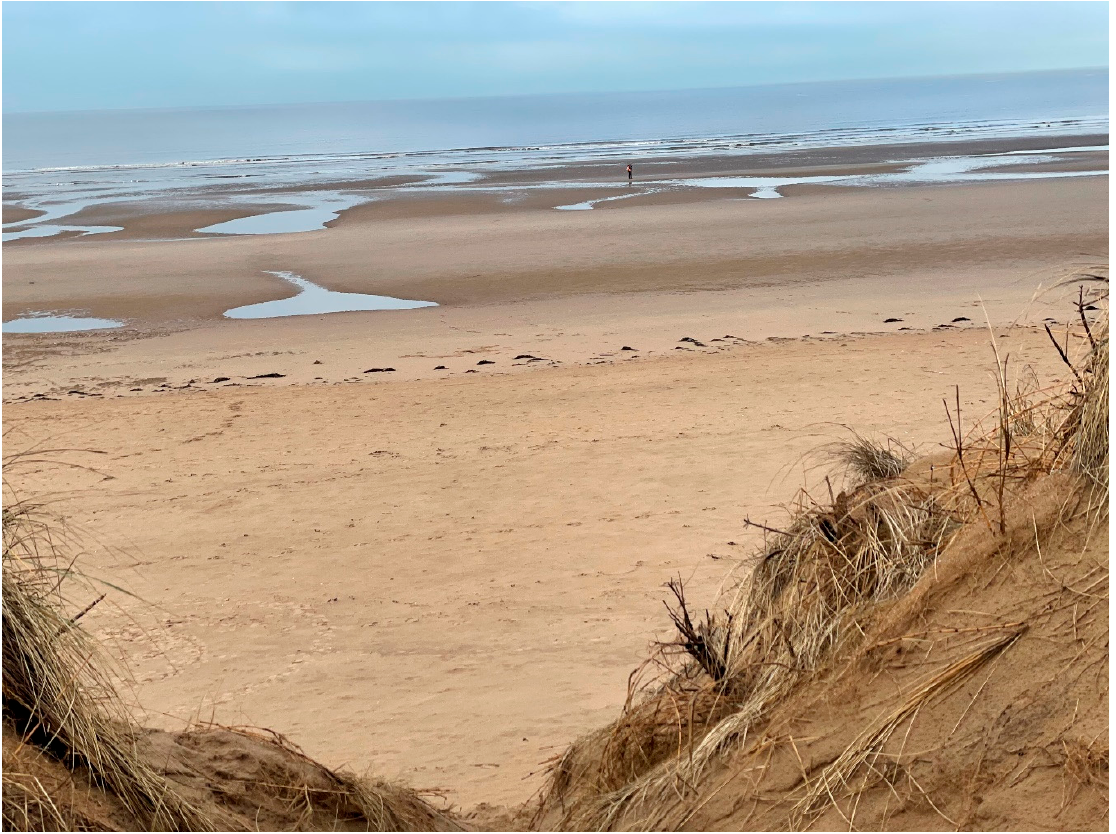
Figure 11. The effect of midday tides on sea water motion at Formby coast. Around midday, the sea water recedes up to 250–300 m from the frontal dunes (view taken from the top of the frontal dunes on the Formby coast).